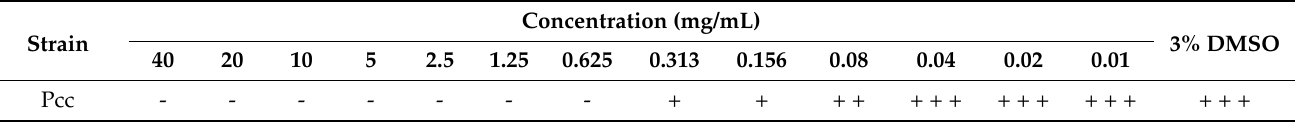
Table 4. Minimum inhibitory concentration (MIC) of Polygonum orientale essential oil against Pectobac- terium carotovorum subsp. carotovorum